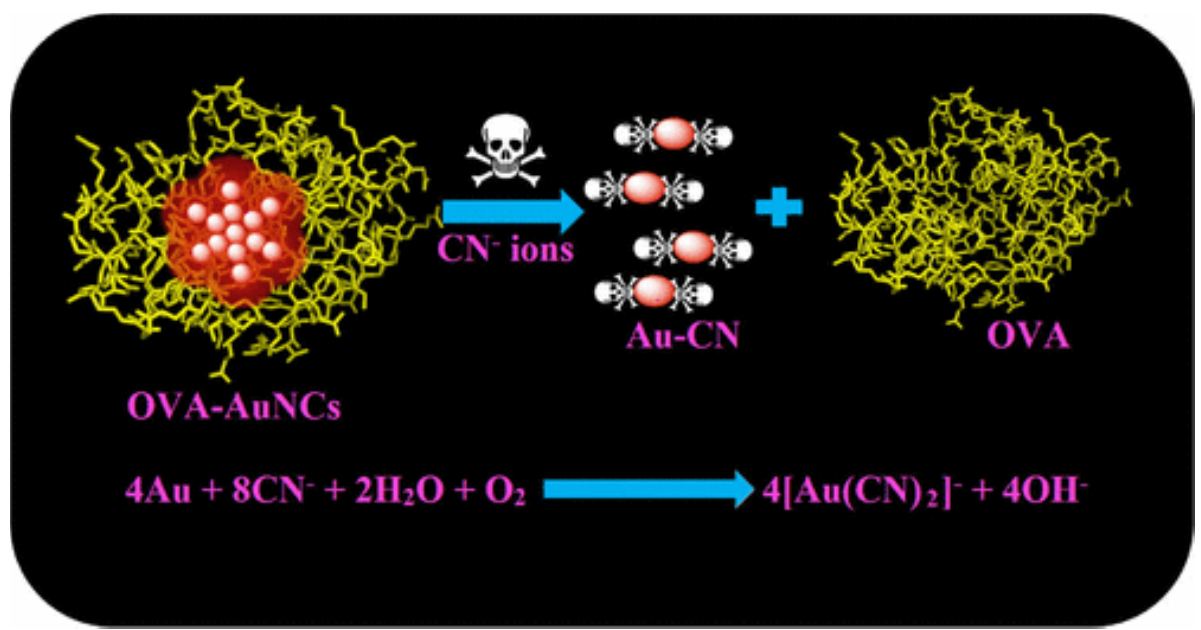
Figure 6. Schematic design of the sensing mechanism for the interaction of cyanide anion and ovalbumin-AuNCs. Figure reproduced from Ref. [116] with permission from the American Chemical Society.